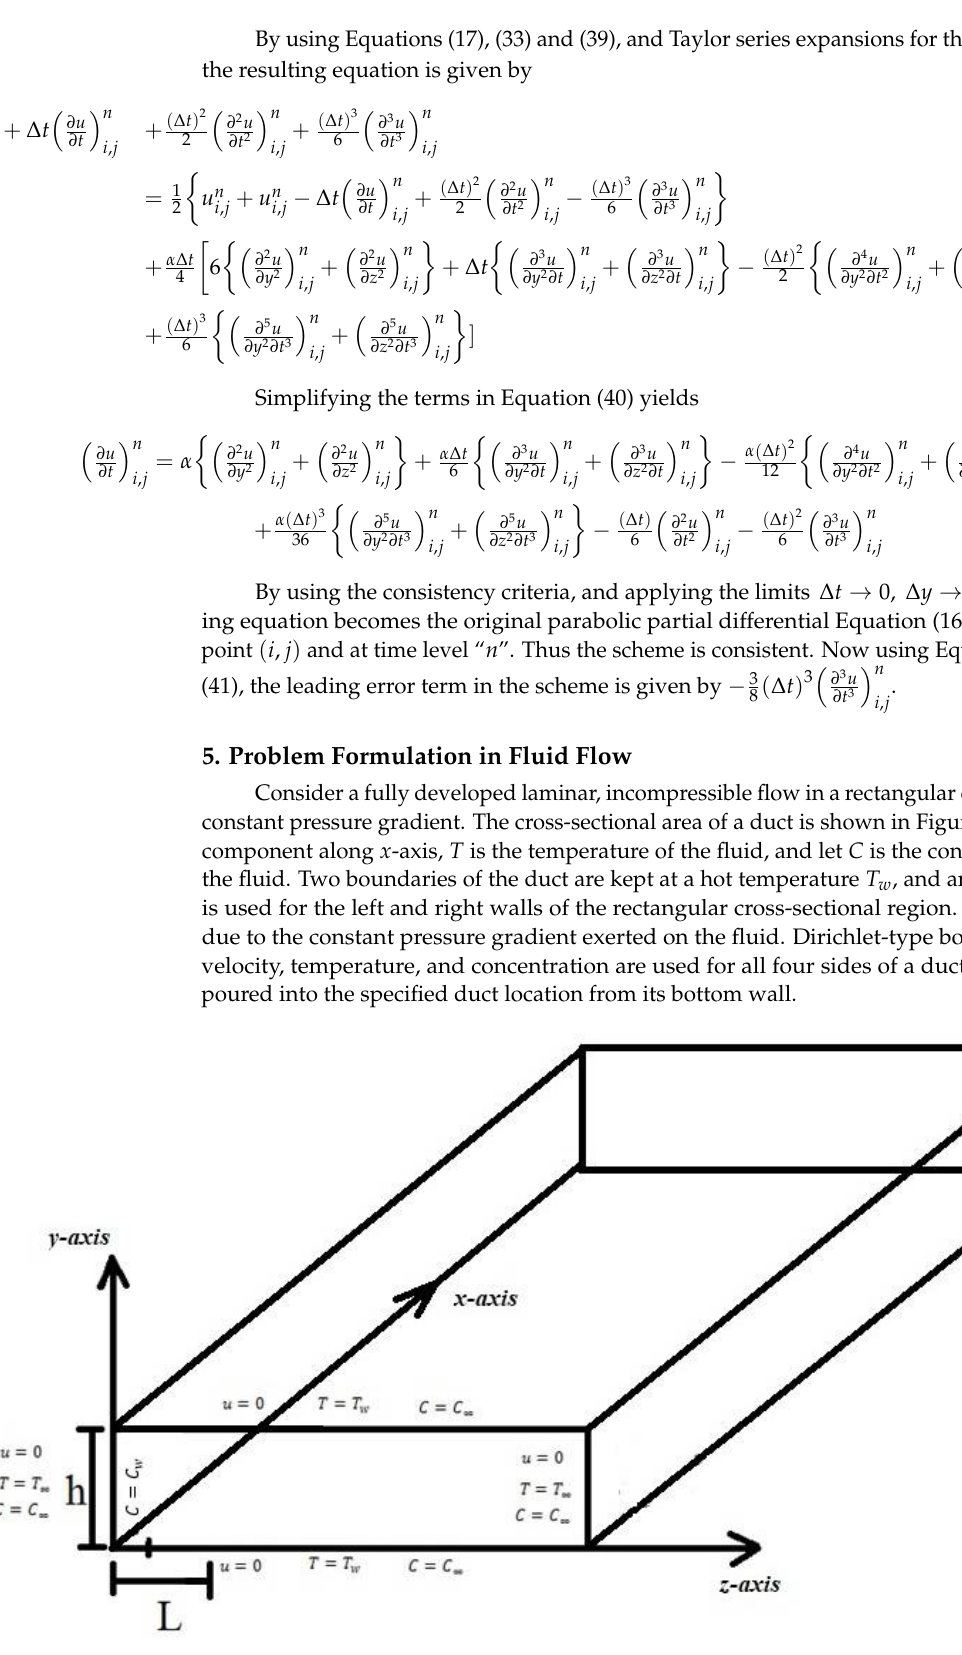
Figure 1. Two-dimensional geometry for the cross-section of rectangular duct.